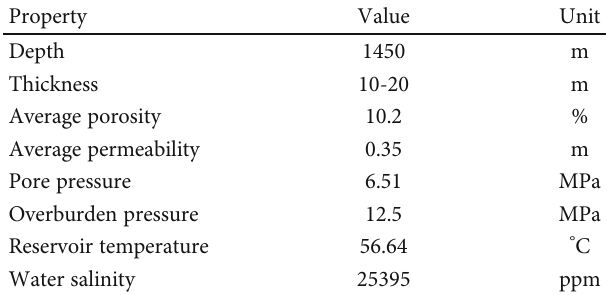
Table 1: Geological properties of the Chang VIII